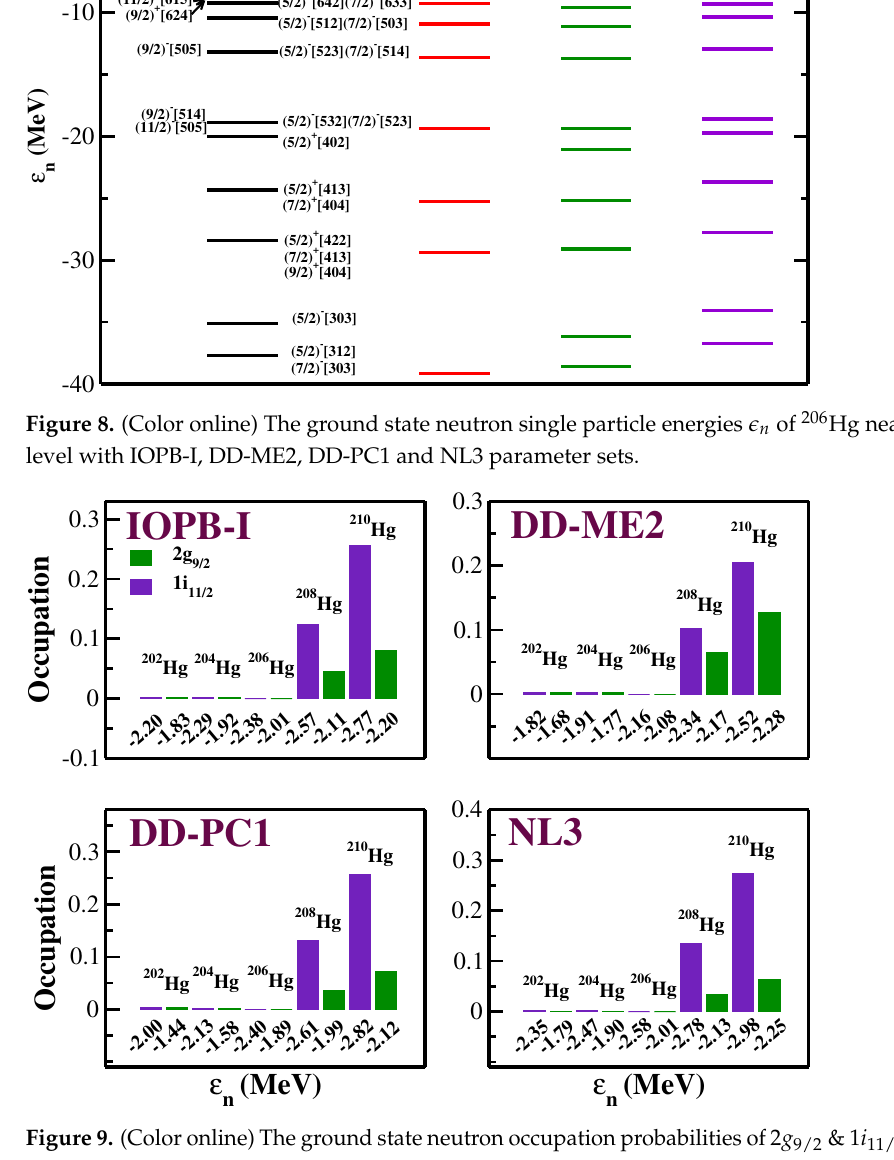
Figure 9. (Color online) The ground state neutron occupation probabilities of 2 g 9/2 & 1 i 11/2 orbitals as a function of their respective single particle energies (cid:101) n for the considered IOPB-I, DD-ME2, DD-PC1 and NL3 parameter